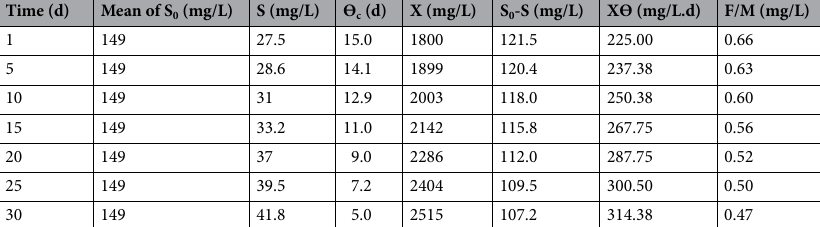
Table 5. The functional and operational parameters by application of the SMFs on ASM